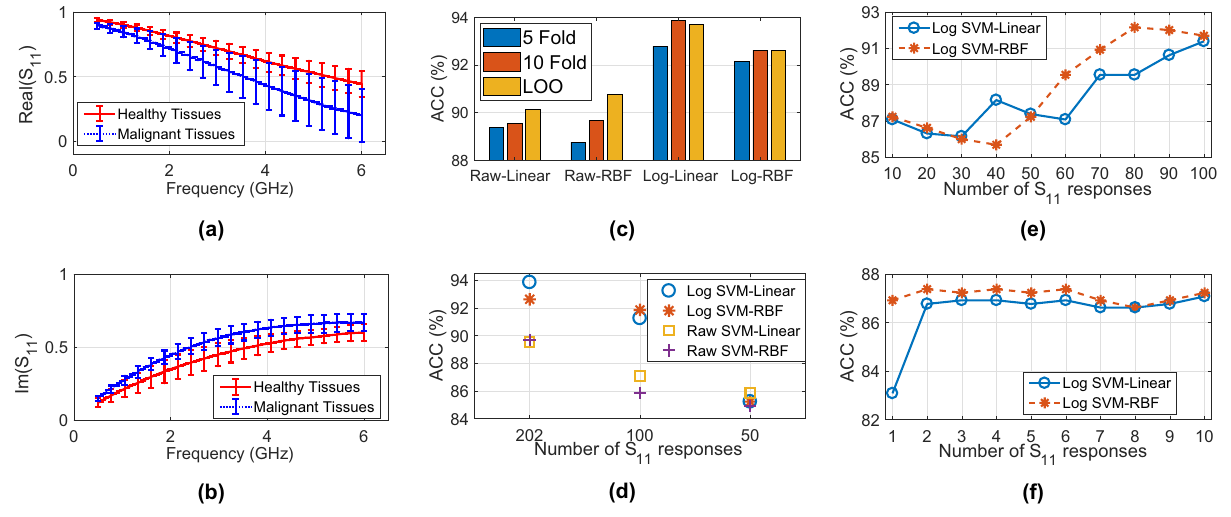
Figure 2. Classification pipeline of the rat mammary carcinoma, from data acquisition to analysis. ( a ) Real part of the antenna S 11 response when terminated with in vivo rat mammary tissues. ( b ) Imaginary part of the antenna S 11 response when terminated with in vivo rat mammary tissues. ( c ) Accuracy (ACC) comparison of the Support Vector Machines (SVM) with linear and Radial Basis Function (RBF) kernels applied to raw and logarithm of the raw data (S 11 response) using different cross-validation (CV) schemes. ( d ) ACC comparison for all 202, first 100, and first 50 S 11 response (features) for raw and logarithm of raw data with SVM algorithms with linear and RBF kernels. ( e ) ACC comparison of SVM with linear and RBF kernel for top scored S 11 response (feature) numbers varying from 10 to 100. ( f ) ACC comparison of SVM with linear and RBF kernel for top scored S 11 response (feature) numbers varying from 1 to